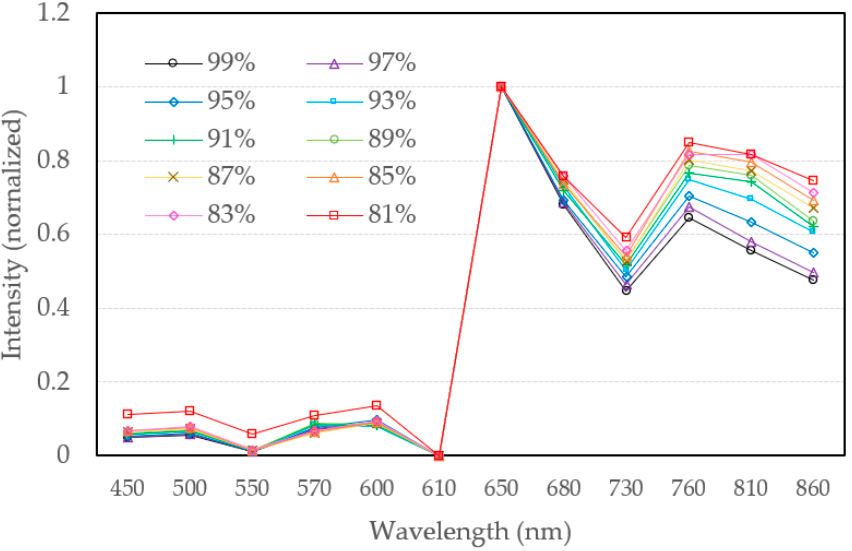
Figure 6. Normalized multi-channel spectral graphs with different concentrations.